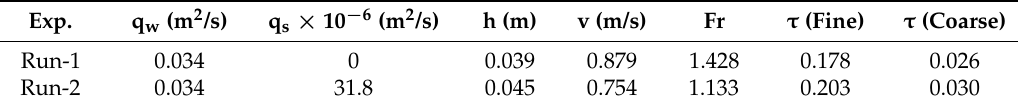
Figure 10. Schematic drawing of experimental channel and apparatus [16]. Table 2. Experimental conditions for two runs, where: q w —water discharge; q s —sediment discharge; Fr—Froude number; τ—non‐dimensional bed shear stress [ 16 ] .